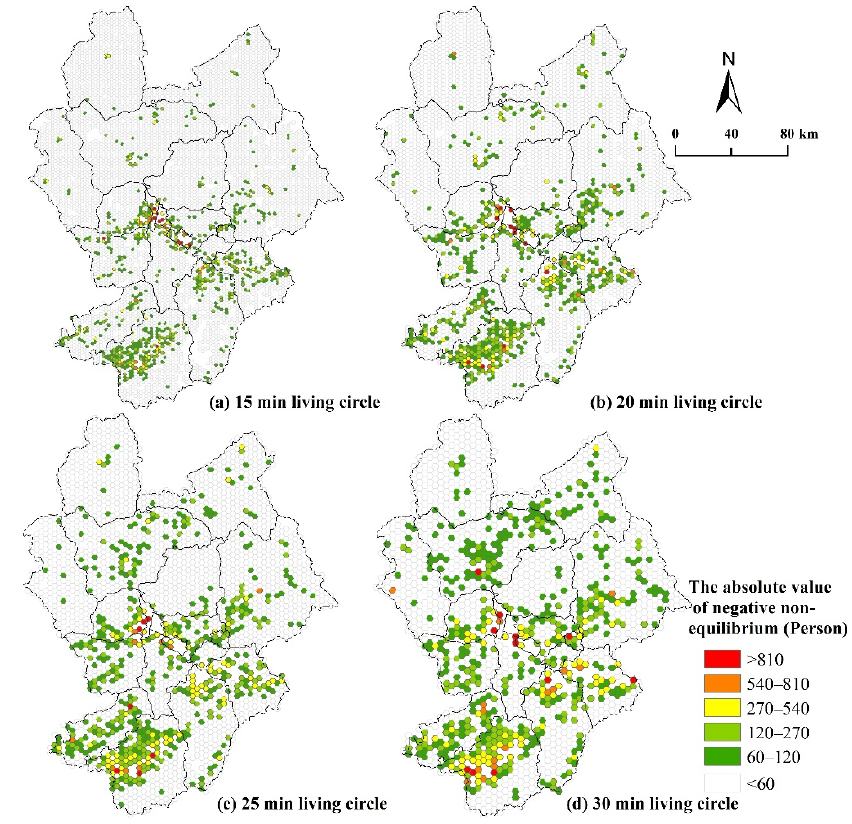
Figure 8. Optimization maps for four living circle scenarios lacking primary schools. Table 4. Statistical results for four living circle scenarios lacking primary school.